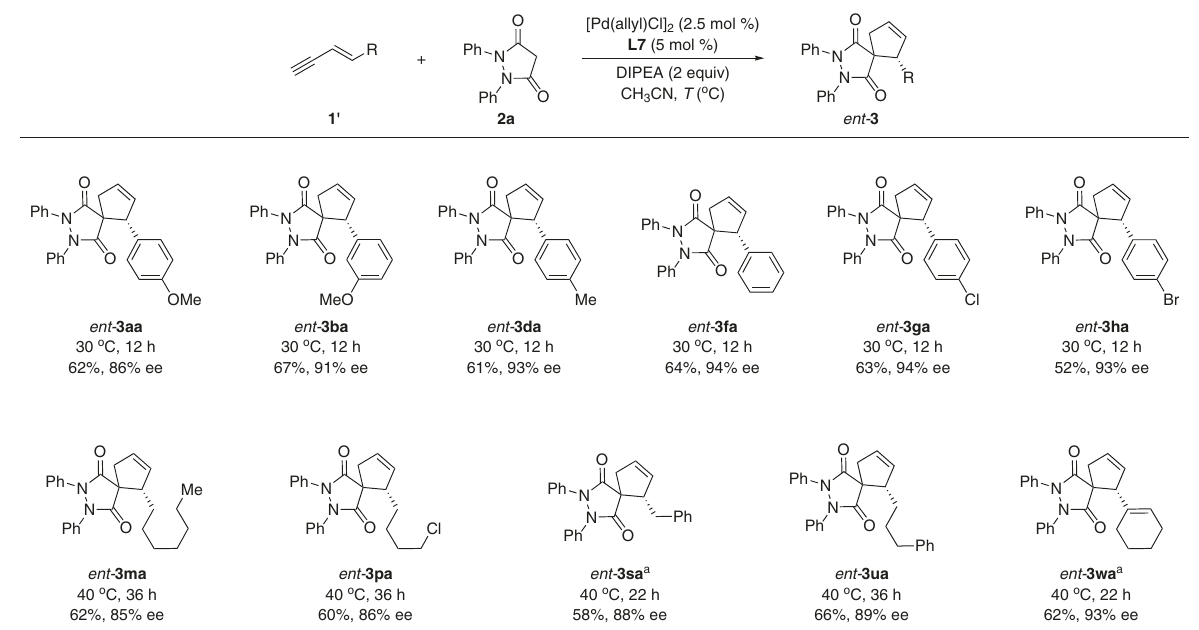
Fig. 3 Pd/WingPhos catalyzed cycloaddition of 1,3-enynes having a triple bond with enantioselectivity switch. The reactions were carried out on a 0.1- mmol scale. Isolated yields are reported. a L8 was used as ligand. DIPEA N,N -diisopropylethylamine.